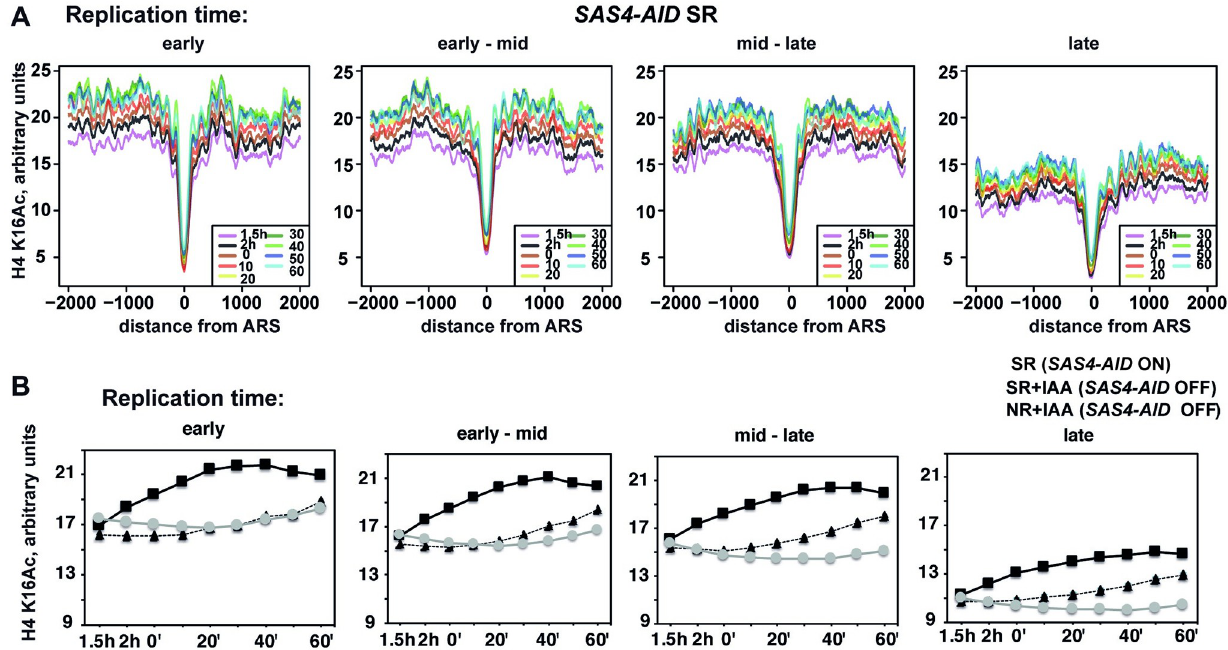
Fig 4. Dynamics of H4 K16Ac on origins of replication during replication. H4 K16Ac increased later on late-replicating origins. (A) Profiles of H4 K16Ac 2 kB upstream and downstream of ARS sequences. Origins were grouped according to their time of replication (from left to right: the earliest 25% of ARS (“early”); second earliest origins (25–50%, “early—mid”); later origins (50–75%, “mid—late”); latest origins (“late”). (B) H4 K16Ac was averaged over the cluster of ARS (ARS +/- 2 kB, but excluding 500 bp surrounding the ARS) and across the time